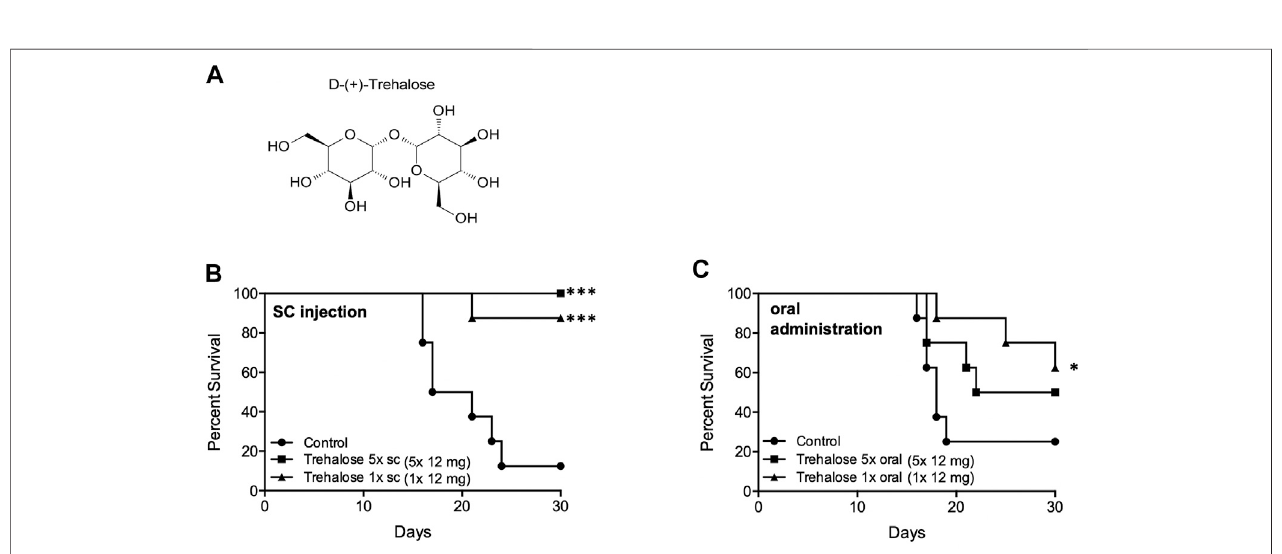
FIGURE 8 | Trehalose (A) and mitigation of radiation damage by (B) Trehalose (s.c., LD70/30), (C) Trehalose (oral, LD70/30). Each dose was 12 mg/animal in water. * p < 0.05, *** p < 0.001.